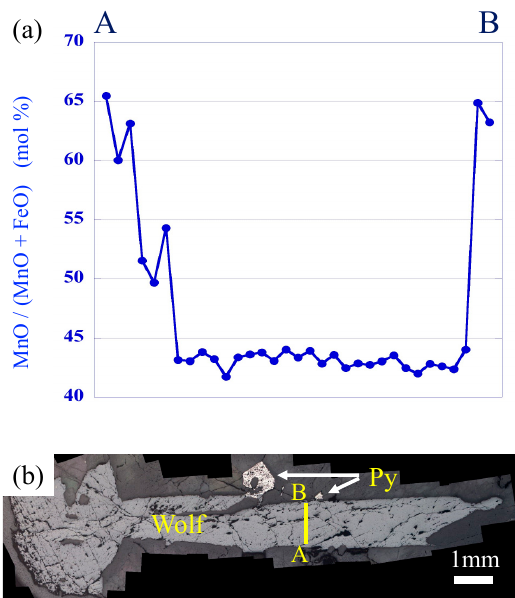
Figure 6. ( a ) Quantitative analyses for Mn and Fe by EPMA. The Mn/Fe ratio is expressed in mol% of MnO/(MnO + FeO). ( b ) The analytical traverse line A–B is shown in the photomicrograph. Wolf: wolframite, Py: pyrite.